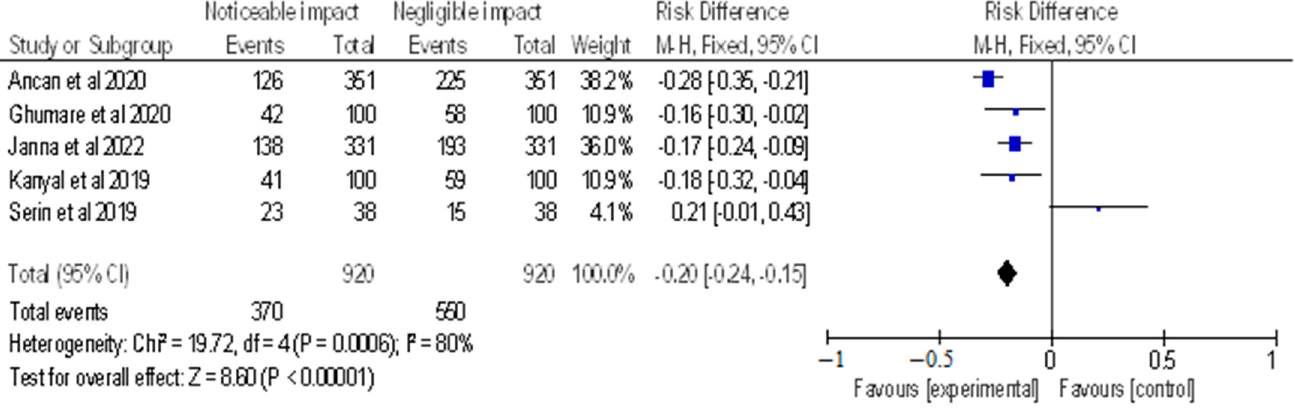
Figure 5. Risk di ff erence of selected cross-sectional, cohort and retrospective investigations repre- sented on a forest plot after their meta-analysis, in which the noticeable impact of Vitamin B12 in- terventions compared to their negative to negligible impact was assessed (where the blue dot rep- resents the study with the most weight and the rhombus represents the total weight of the forest plot). Table 1. AMSTAR-2 16-point checklist of risk of bias assessment in studies selected for the system- atic review.